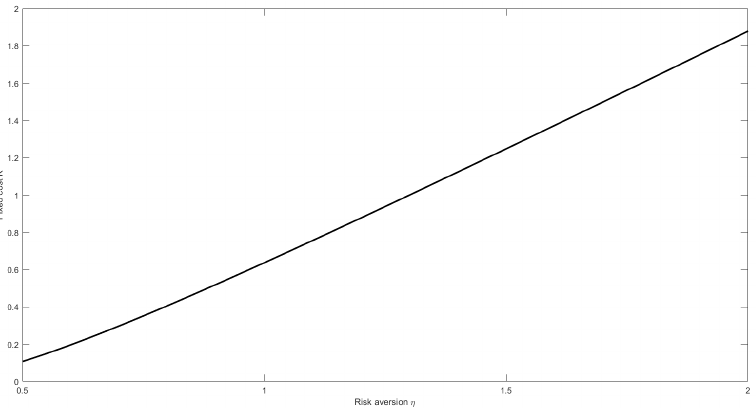
Figure 2. The effect of the risk-aversion parameter η on K ∗ .